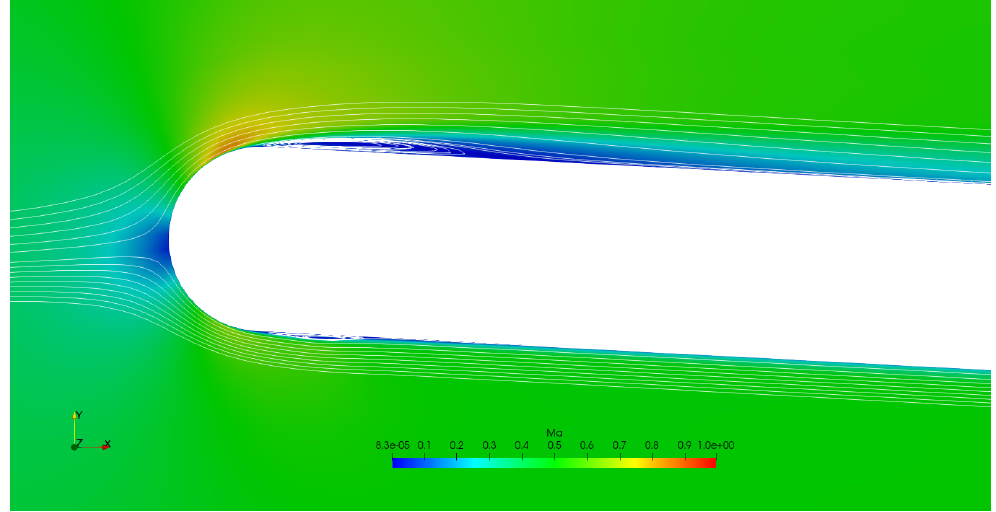
Figure 5. Separation bubbles in the vicinity of the leading edge of the middle blade at α = 3°. The calculated forces acting on the middle blade relative to the results of fine mesh calculation are shown in Figure 6. The vertical component of the force F y (i.e., the lift) is very well resolved, even on the medium mesh, contrary to the horizontal component of the force F x (i.e., the drag). Further mesh refinement may be necessary. Fortunately, the horizontal component of the force plays a minor role in the flutter analysis; therefore, the medium mesh was selected for further